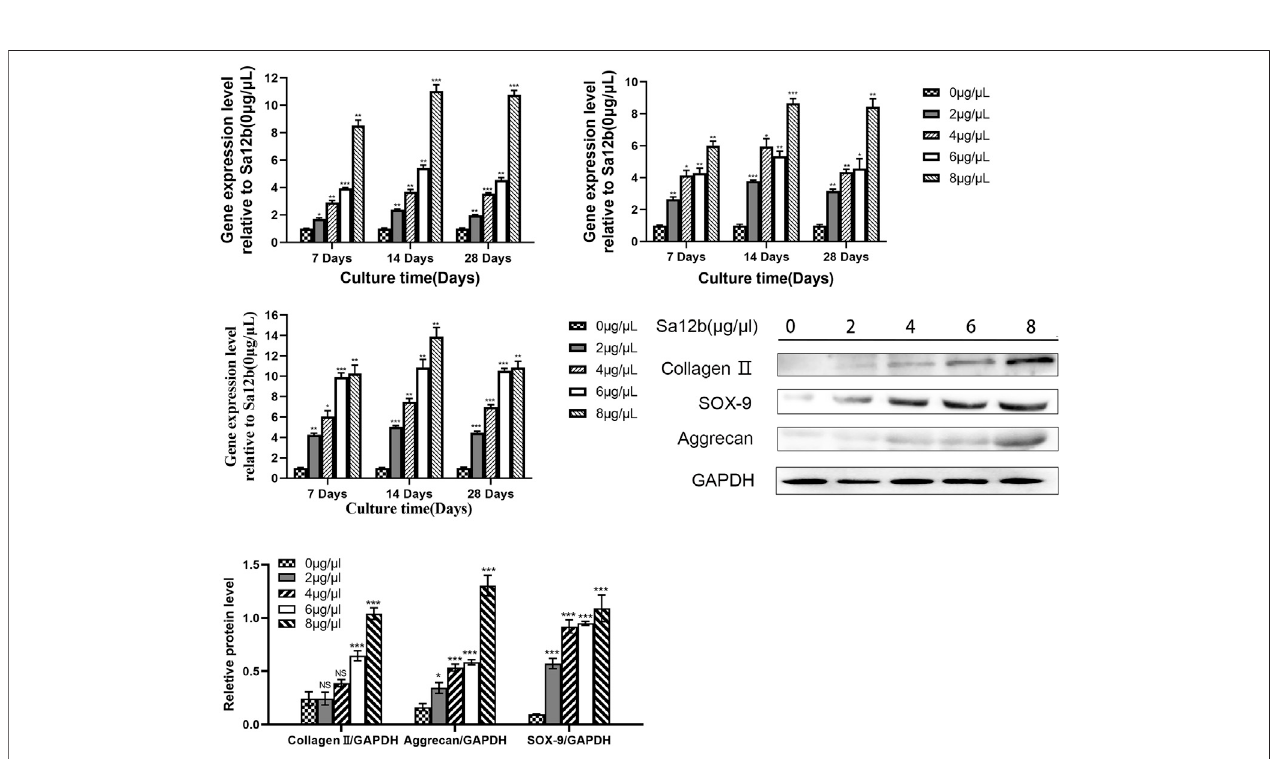
FIGURE 6 | Expression of ECM-related genes (Aggrecan, Collagen II, SOX-9) gradually increased with increasing Sa12b concentration. *indicates p < 0.05; **indicates p < 0.01; ***indicates p < 0.001; NS indicates no statistical signi fi cance when the control group ( Sa12b = 0 μ g/ μ l) was compared with the other groups.